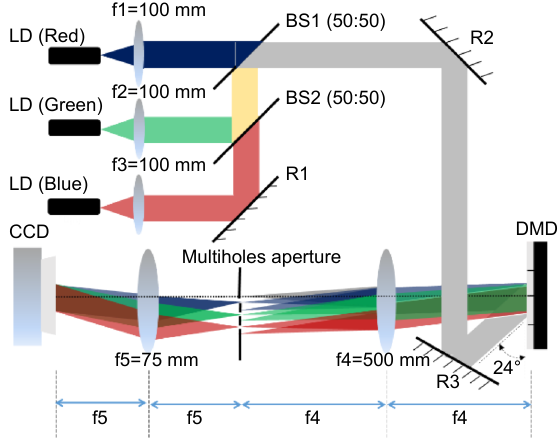
Fig. 3 | Schematic of the color holographic imaging display sys- tem. Three types of color semiconductor laser are collimated, expan- ded and combined, reflected by R2 and R3, and are incident on the DMD panel at 24°. A multi-hole aperture filter is placed at the focal plane of lens f4, and lens f5 is used to reconstruct the image on the color charge-coupled device (CCD) panel. The DMD and CCD pan- els are strictly conjugated by the f4 and f5 lens groups.